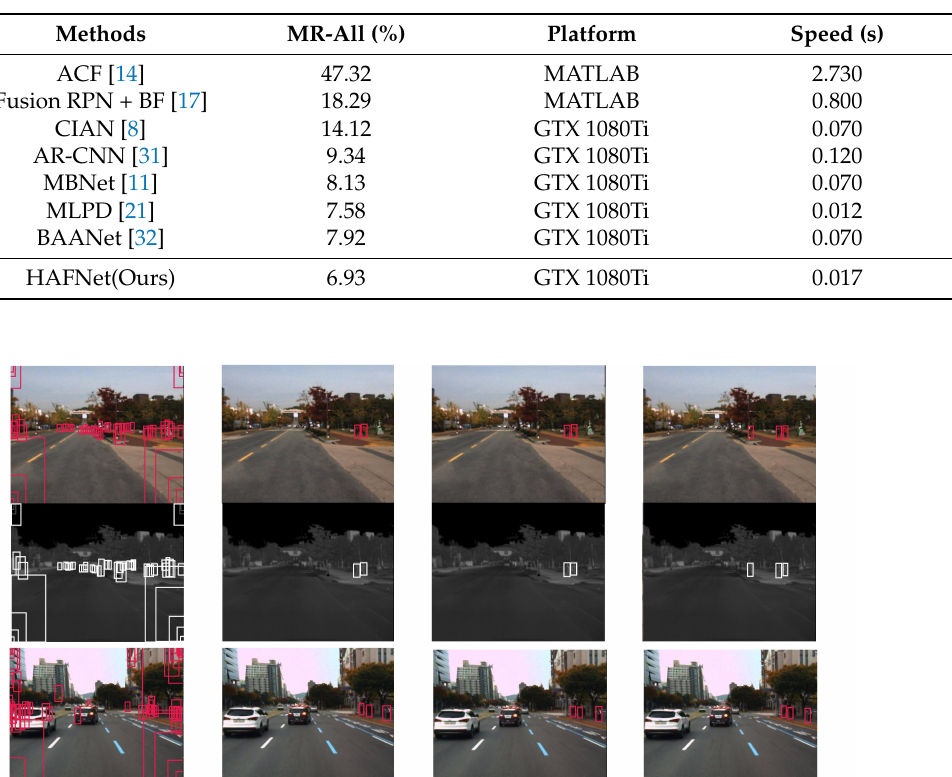
Table 2. Speed comparison between HAFNet and state-of-the-art methods. It should be noted that ACF and Fusion RPN+BF did not provide information on the hardware platform used in the original paper.